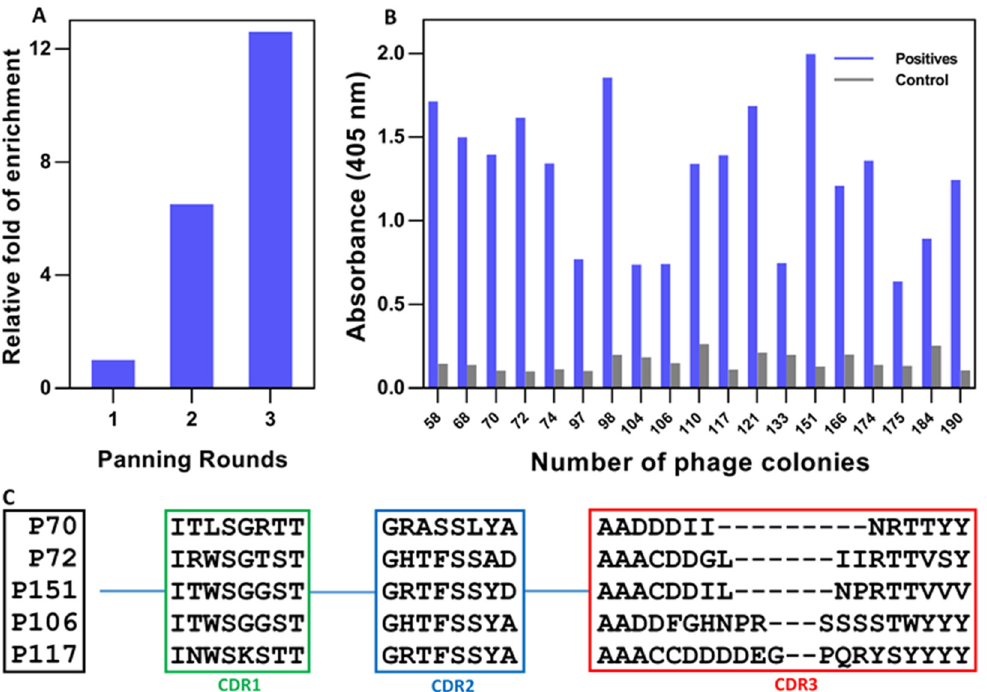
Figure 3. Selection of SF-specific Nbs after bio-panning and screening. ( A ) The relative enrichment of panning rounds. ( B ) The potential positive binders after the screening of specific Nbs by PE-ELISA. ( C ) The amino acid sequence of SF-specific Nbs after sequencing and family classification.